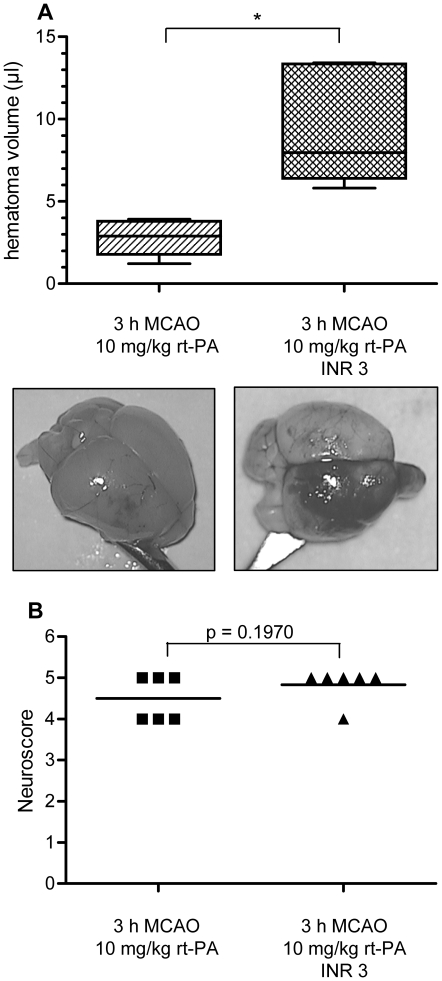
Hemorrhagic transformation after i.v. thrombolysis with rt-PA is excessively increased in effectively anticoagulated mice.A) Mice without prior warfarin intake subjected to 3 h MCAO were treated with 10 mg/kg human rt-PA directly prior to reperfusion (left, n = 5). In comparison, mice anticoagulated to an INR of approximately 3 at the onset of cerebral ischemia (right, n = 5) showed a vast increase in hematoma volume after t-PA treatment. Statistical significance was essayed with student's unpaired, two-tailed t-test. ** p<0.01. B) Neuroscores were analyzed for statistical significance with a one-tailed Mann Whitney test and the p-value given as a Gaussian approximation (median values 4.5 and 5, p = 0.1970).